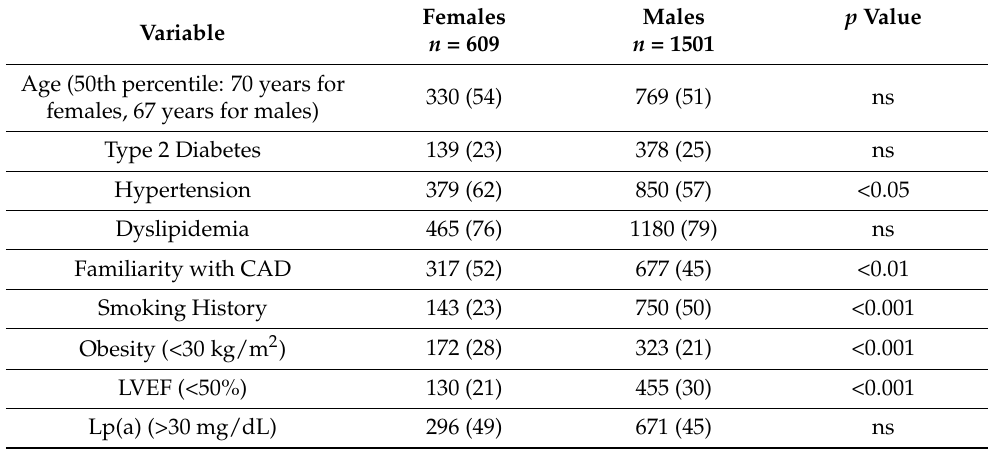
Table 1. Characteristics of the studied population. Variable